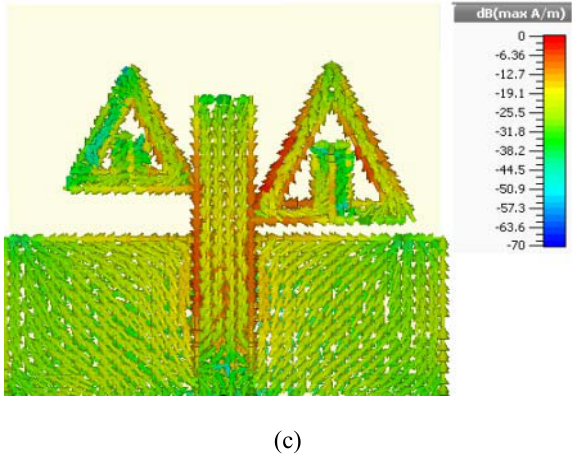
Fig.9 Simulated surface current distribution of proposed antenna at: (a) 2.5GHz, (b) 3.62 GHz, and (c) 5.83